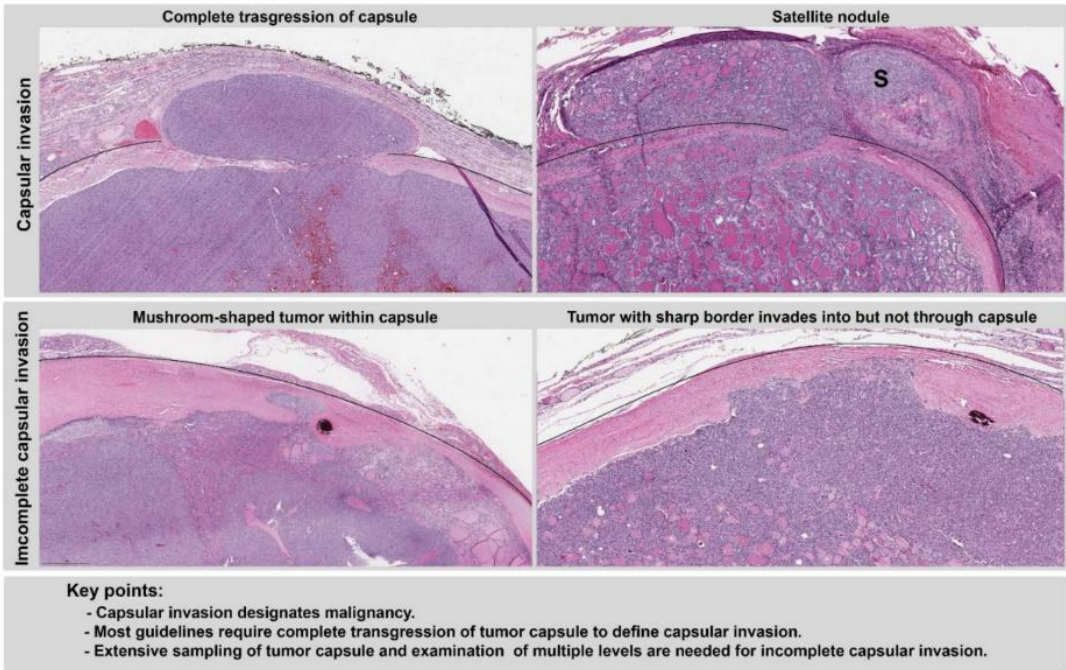
Figure 2. Capsular invasion. Upper panels: capsular invasion is defined as complete transgression of the capsule or satellite nodule(s) lying outside of the tumor capsule. Lower panels: incomplete capsular invasion is defined as incomplete penetration of the tumor capsule. Black lines outline the outer contour of tumor capsule. S: satellite nodule. Magnification: 40 ×